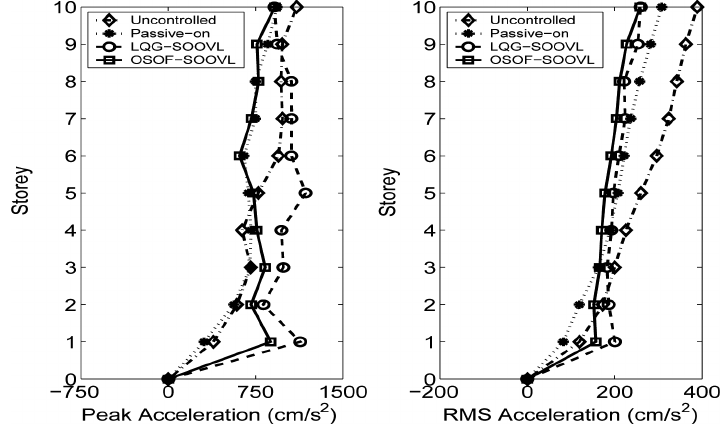
Fig. 6. Storeywise peak and RMS accelerations.